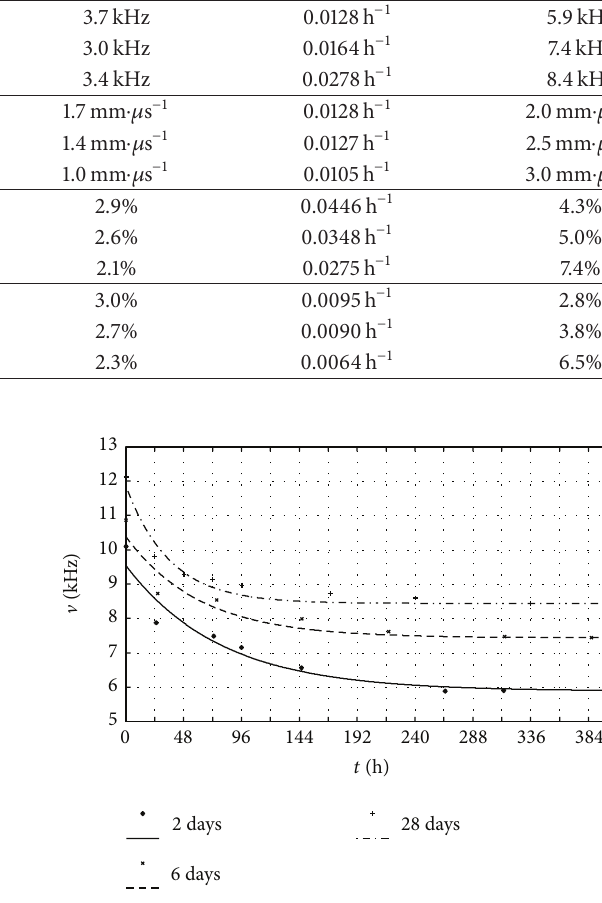
Figure 2: Ultrasound velocity. Figure 3: Maximal frequency component of impact echo